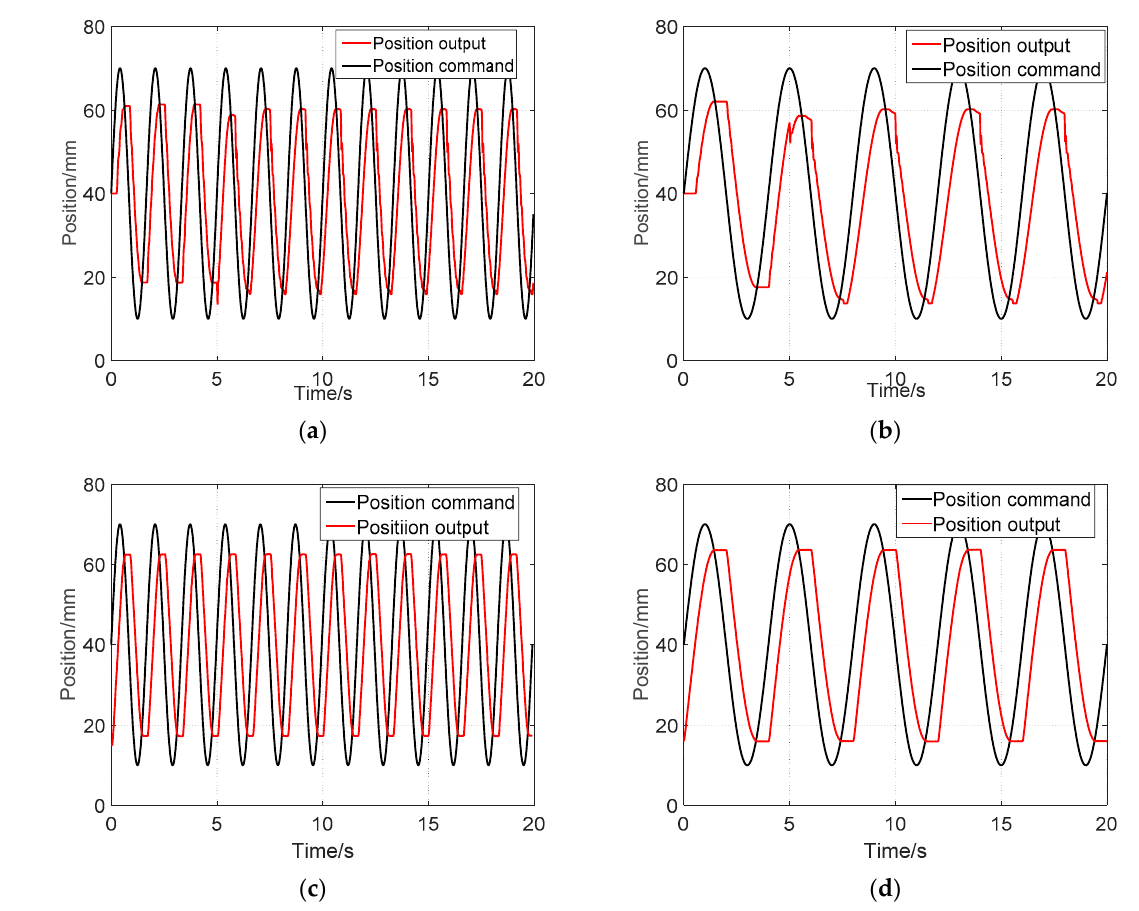
Figure 18. The result of the position in the closed-loop sinusoidal simulation experiment with the different proportional coefficients and different frequencies. ( a ) simulation results when proportional 20 with 0.63 Hz. ( b ) simulation results when proportional 10 with 0.25 Hz. ( c ) experimental results when proportional 20 with 0.63 Hz. ( d ) experimental results when proportional 10 with 0.25 Hz. It indicates that the cut-off frequency of the closed-loop system with a proportional